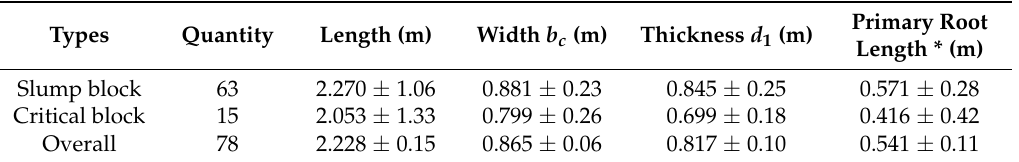
Table 4. In situ measured average dimensions of failed blocks by failure manner in comparison with root length.